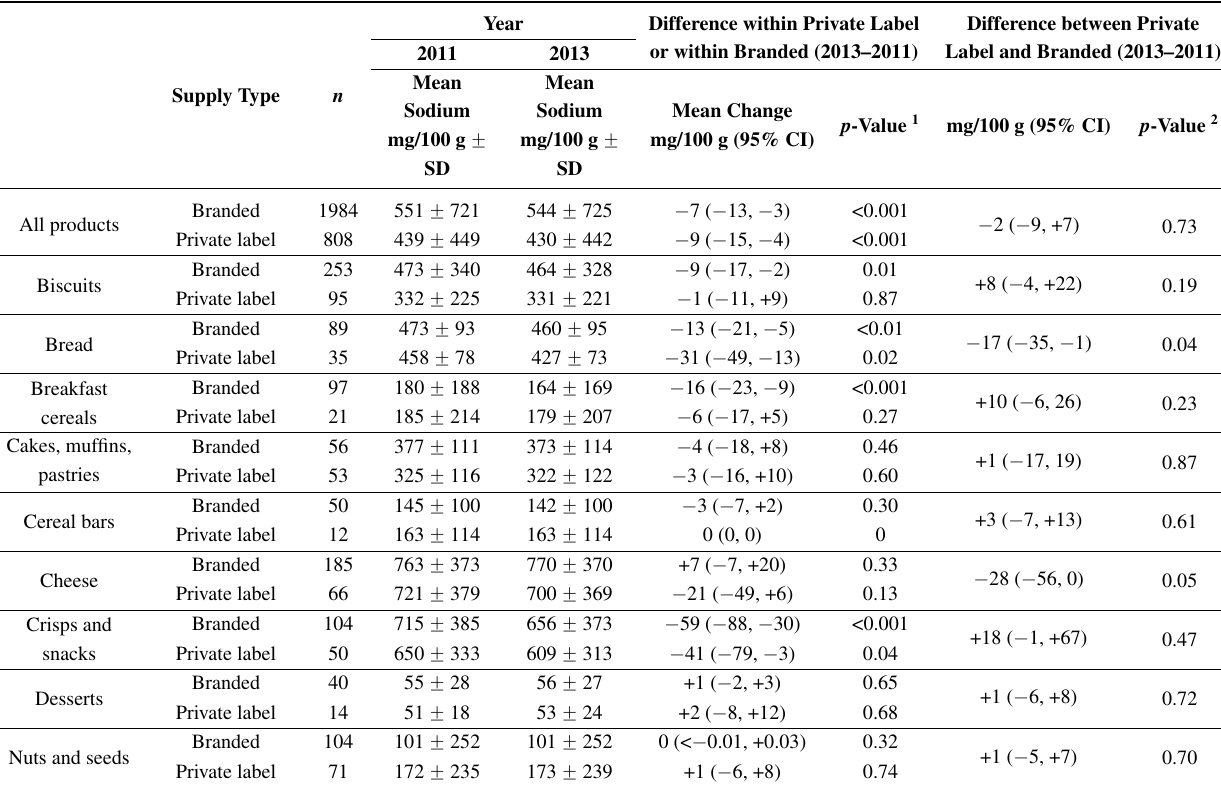
Table 2. Mean sodium levels (mg/100 g) in supermarket private label and branded products on the supermarket shelves in both 2011 and 2013 and the differences between them over those three years, overall and for 15 major food